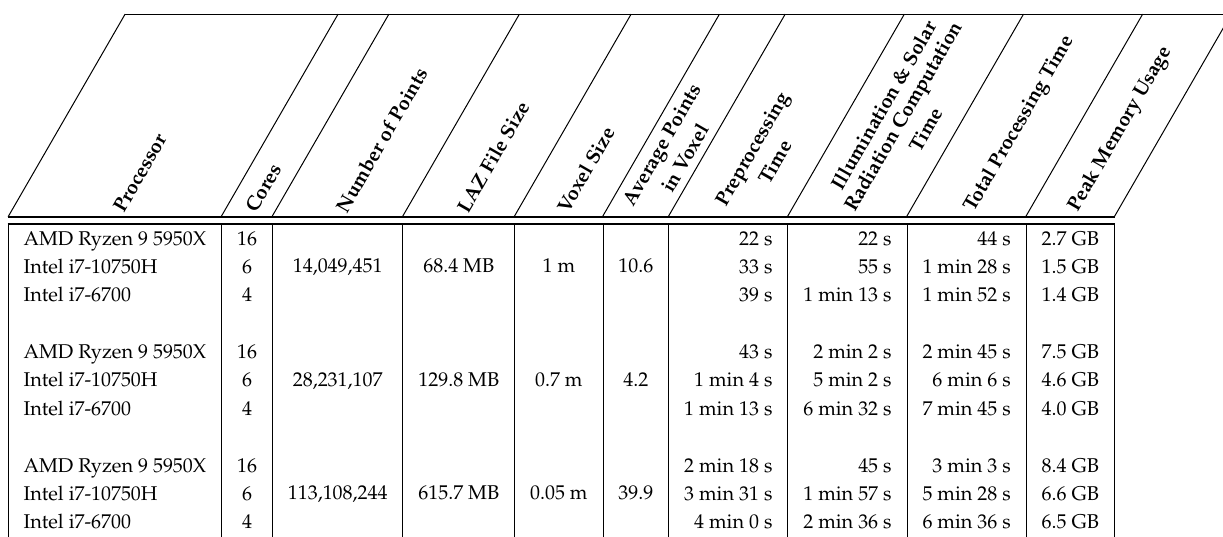
Table 1. Comparison of the performance with different types of point clouds and on different hard-